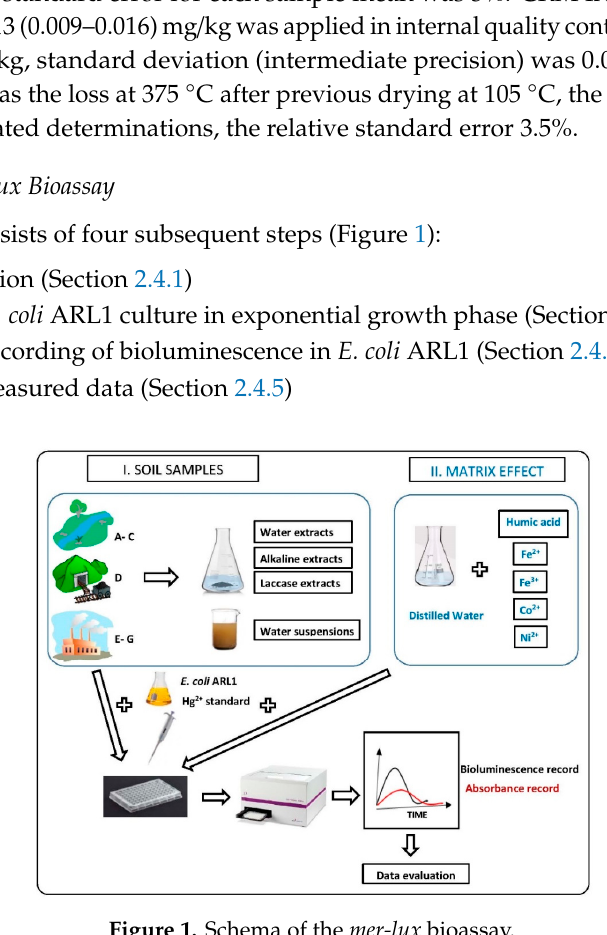
Figure 1. Schema of the mer-lux bioassay.